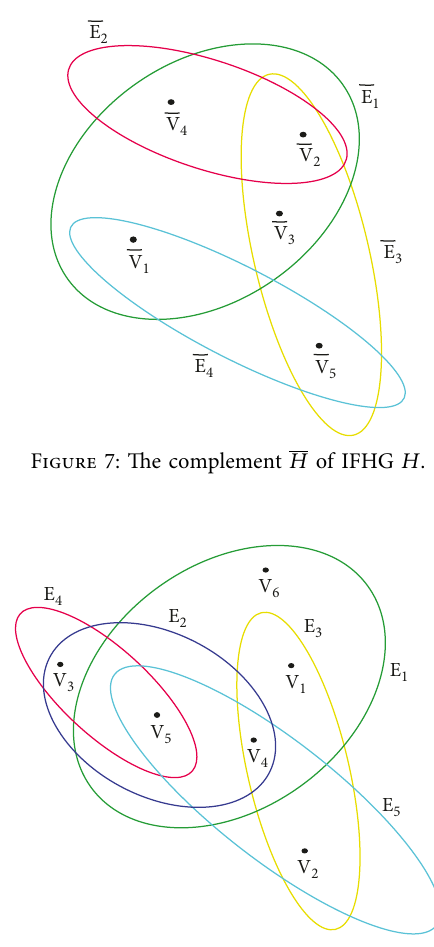
Figure 8: Double dominating set D